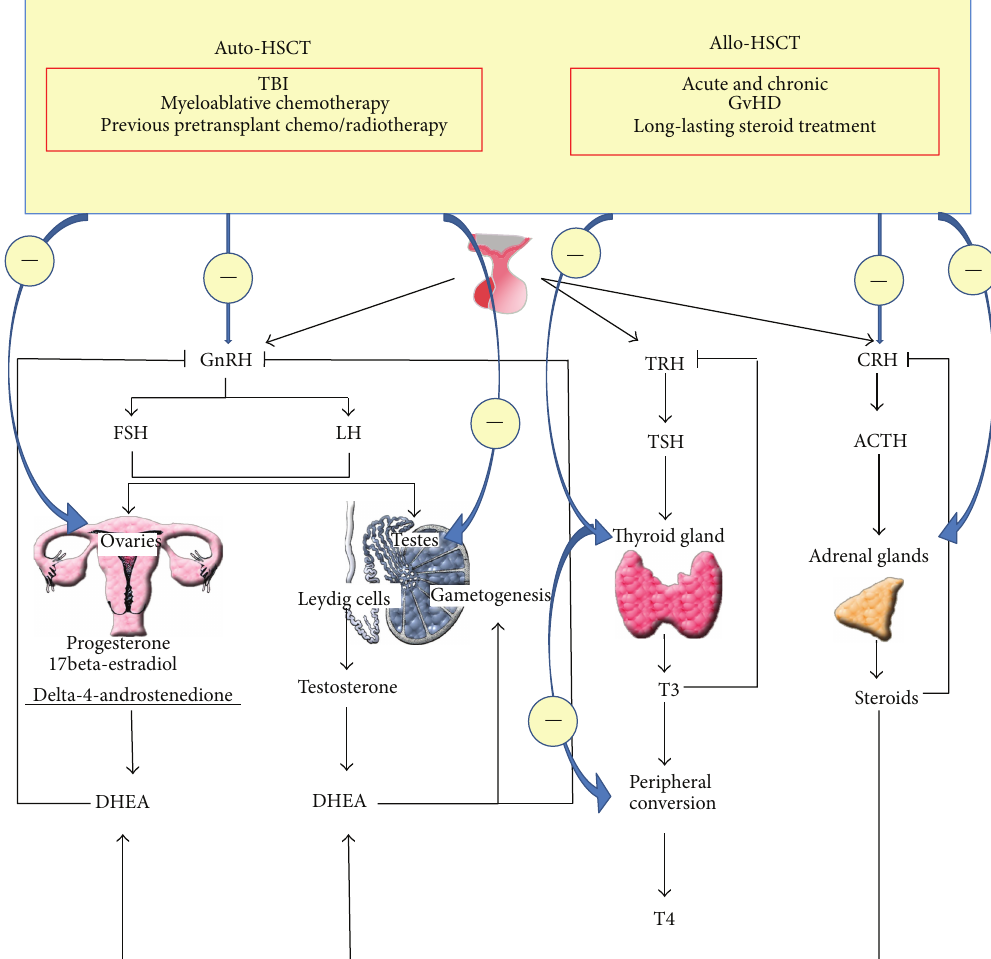
Figure 1: Main endocrine abnormalities after hematopoietic stem cell transplantation. Auto-HSCT and allo-HSCT: autologous- and allogeneic-hematopoietic stem cell transplantation; GnRH: gonadotropin releasing hormone; FSH: follicle-stimulating hormone; LH: luteinizing hormone; DHEA: dehydroepiandrosterone; TBI: total body irradiation; cGvHD: chronic graft-versus-host disease; ACTH: adrenocorticotropic hormone; CRH: corticotropin-releasing hormone; T4: thyroxine; T3: triiodothyronine; TSH: thyroid-stimulating hormone; TRH: thyrotropin releasing hormone. Symbol ( − ) means